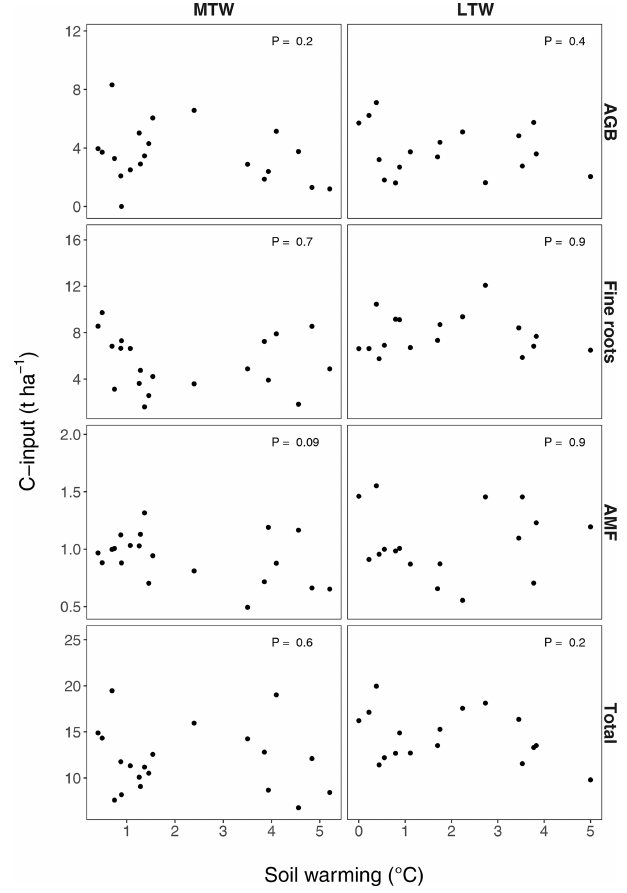
Figure B3. Proxies for annual soil C inputs from aboveground biomass (AGB), fine root biomass and arbuscular mycorrhizae (AMF) in the medium-term warmed (MTW) and the long-term warmed (LTW) grasslands. Vascular plant aboveground biomass was used as a proxy for aboveground C inputs, vascular plant fine root biomass for belowground C inputs and C sequestered by AMF (C new ; data from Zhang et al., 2020) for C inputs by arbuscular my- corrhizae. For the observed soil warming range (0–6.4 ◦ C warm- ing), no change in C inputs could be found. P values were obtained by a linear regression analysis. ( n = 20 and n = 17 for MTW and LTW inputs respectively.)